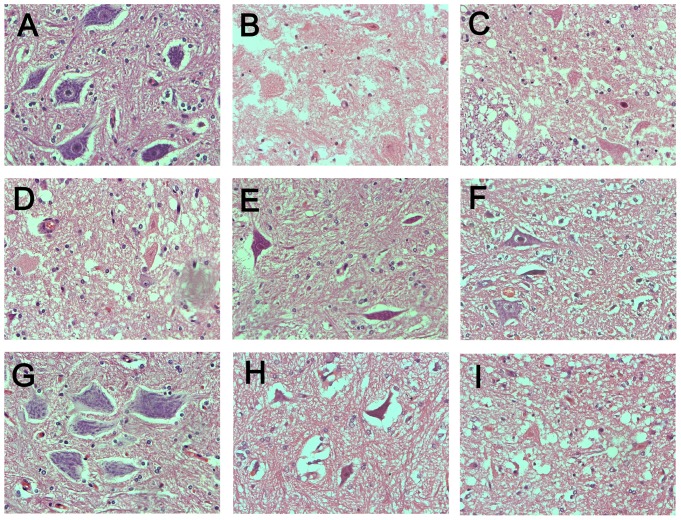
Hematoxylin and eosin staining in the anterior horn of spinal cord.(A) The sham group showed no specific histopathological change. (B) The I/R group showed marked vacuolization and significant loss of α-motor neurons. (C) The NS group showed a similar histopathological appearance to the I/R group. (E–H) Histopathological damage was attenuated in C0.01, C0.05, C0.1, and C0.5 groups. The α-motor neurons were preserved most in the C0.1 group. (D and I) The C0.005 and C1 groups showed no significant neuroprotection (original magnification, 40× object lens). I/R = ischemia-reperfusion; NS = normal saline; C0.005-C1 = clenbuterol 0.005–1 mg/kg.